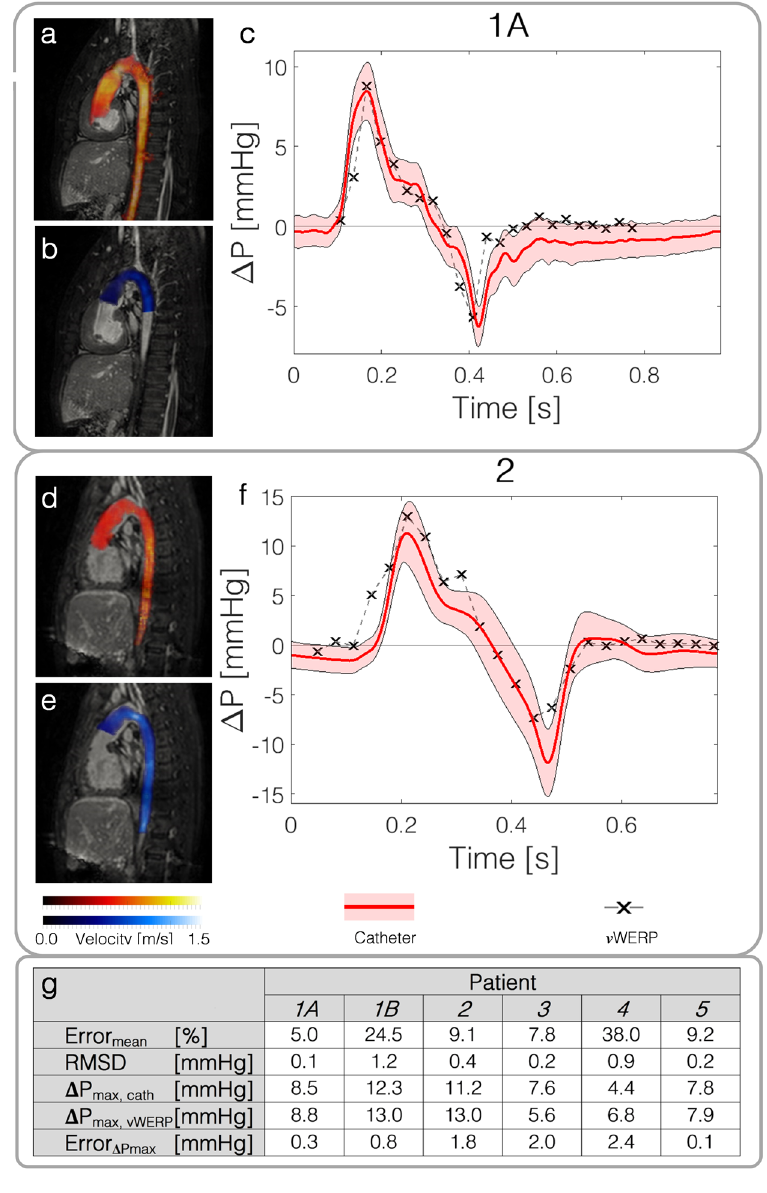
Figure 5. Validation of ν WERP against invasive catheter measurements in the aortic arch of a cohort of complex congenital heart disease patients. (a , d) Acquired flow field patients 1 A and 2. (b , e) Computed virtual field, isolating the domain of interest over which relative pressure estimates are derived. (c , f) Relative pressure estimation from inlet to the diaphragm level of the descending aorta by catheterisation (red continuous line with distribution) and ν WERP (black glyphs with dashed grey line). (g) Table summarising the results for the entire cohort, indicating mean error, root-mean square difference (RMSD), peak relative pressure by catheterisation and ν WERP, respectively, as well as the corresponding absolute